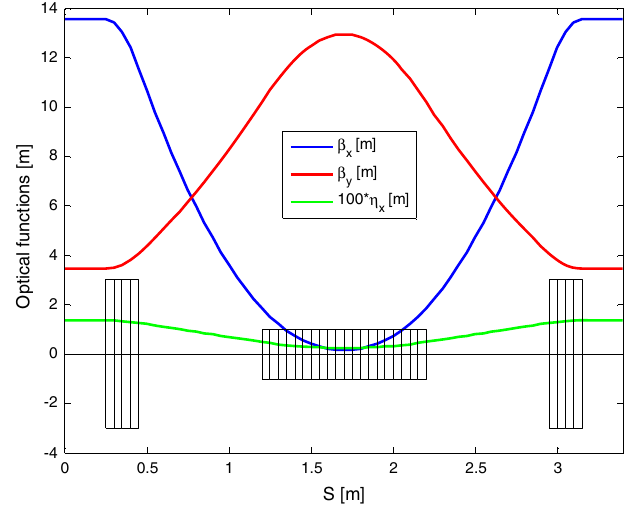
FIG. 9. Optical functions in one standard modified-TME cell for PEP-X storage